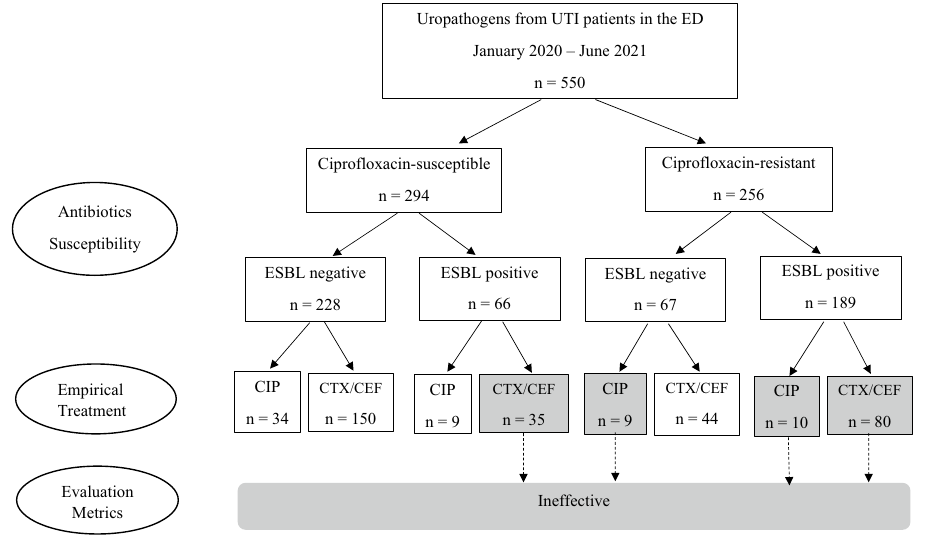
Figure 1. Antibiotics susceptibility of the uropathogens and empirical antibiotics used in the emergency department